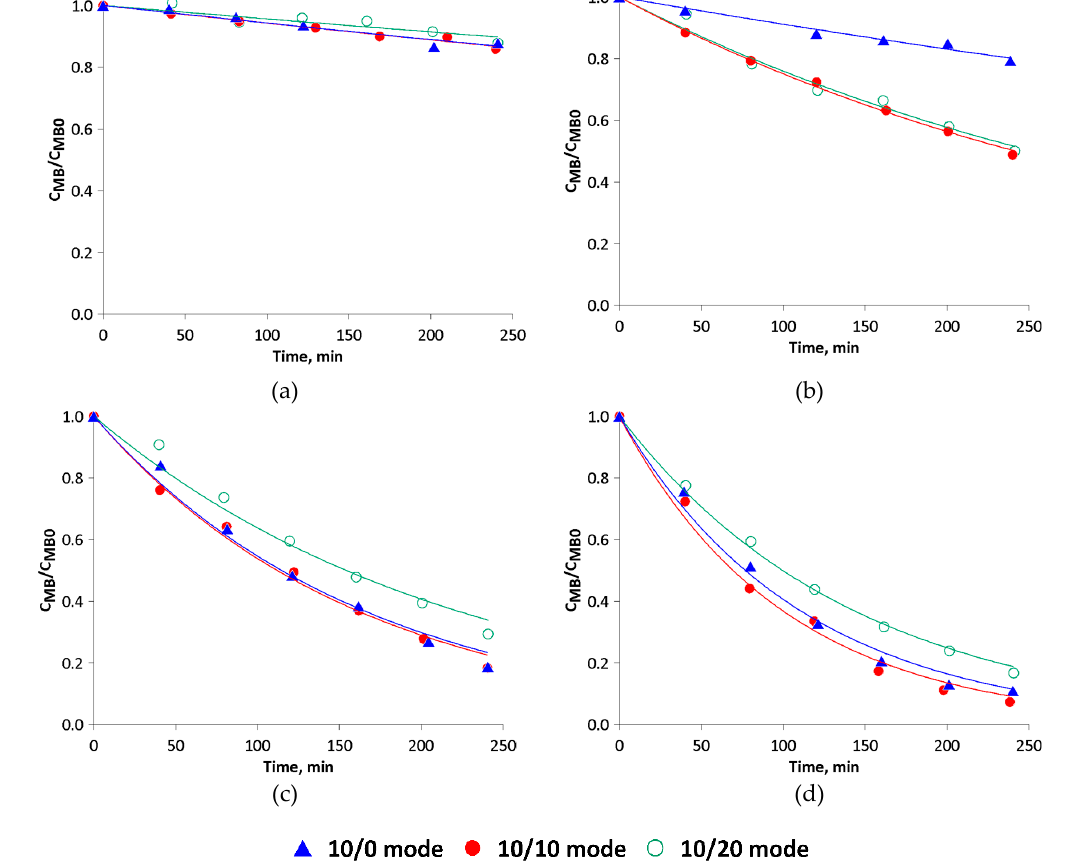
Figure 9. MB concentration changes with experiment time for different catalyst masses: ( a ) 0 g (photolysis), ( b ) 0.5 g, ( c ) 1 g, ( d ) 2 g.